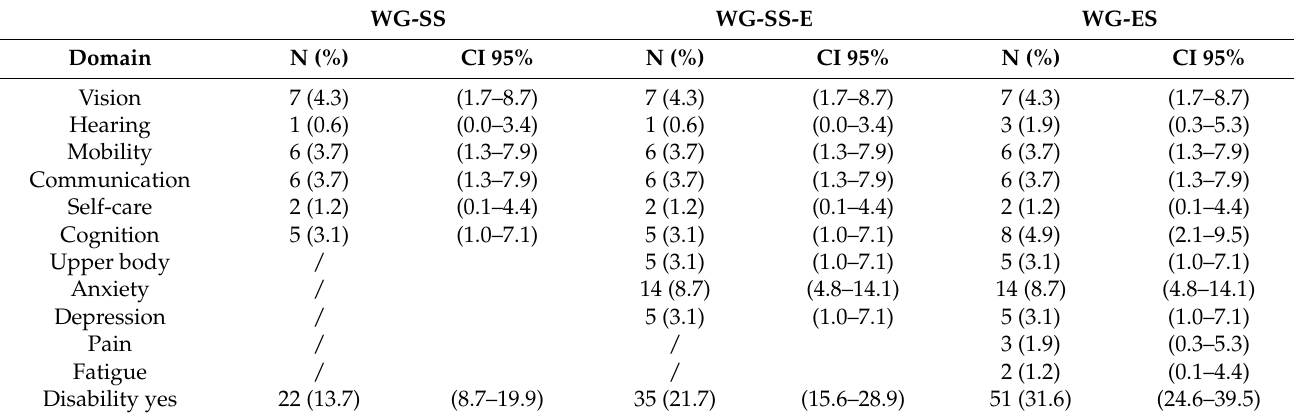
Table 3. Differences in the proportion of migrants with disabilities using WG tools.